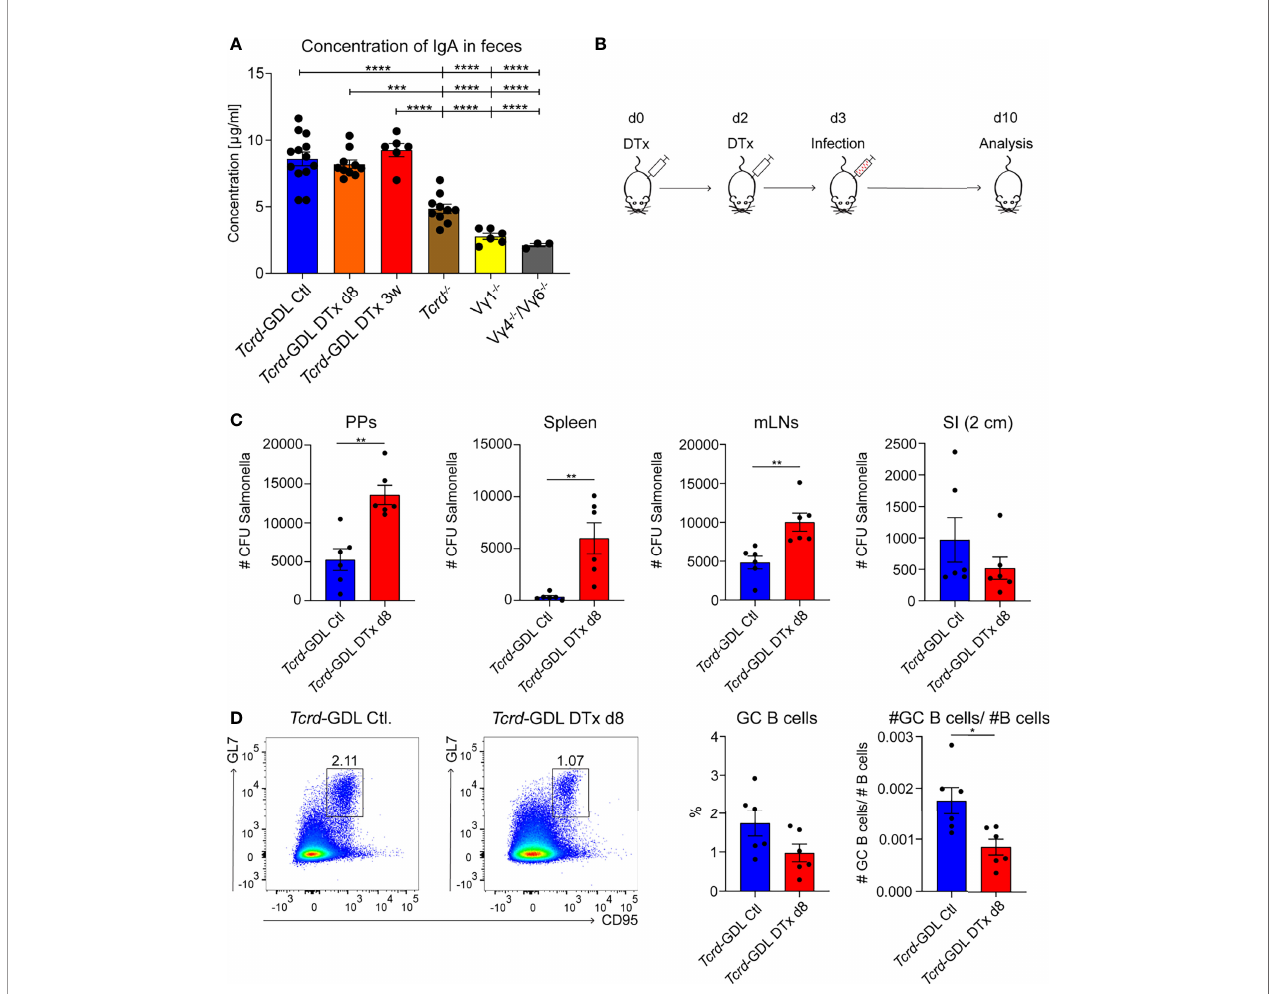
FIGURE 6 | gd T cells contribute to the immune response against Salmonella infection. (A) Concentration of IgA isolated from feces of non-depleted and gd T cell – depleted (8 days and 3 weeks) Tcrd -GDL, Tcrd − / − , V g 1 − / − , and V g 4 − / − /V g 6 − / − mice were measured by ELISA. Bar graph, mean ± SEM. n = 3 – 12 per group. ANOVA test was applied with Tukey post-hoc test. (B) Non-depleted or depleted Tcrd -GDL mice were orally infected for 7 days with Salmonella and analyzed at day 10. (C, D) Non-depleted Tcrd -GDL or depleted Tcrd -GDL mice were orally infected for 7 days with Salmonella . (C) Quanti fi cation of colony-forming units (CFUs) from PPs, spleen, mesenteric lymph nodes (mLNs), and small intestine (SI) of non-depleted and gd T cell – depleted (8 days) Tcrd -GDL mice. Bar graphs, mean ± SEM. n = 5 – 6 per group. T-test was applied. (D) Analysis of germinal center (GC) B cells (CD19 + , CD138 − , GL7 + , CD95 + ) of non-depleted and gd T cell – depleted (8 days) Tcrd -GDL mice after Salmonella infection. Bar graphs, mean ± SEM. n = 6 per group. T-test was applied. Each dot represents an individual mouse. *P < 0.05, **P < 0.01, ***P < 0.001, ****P <